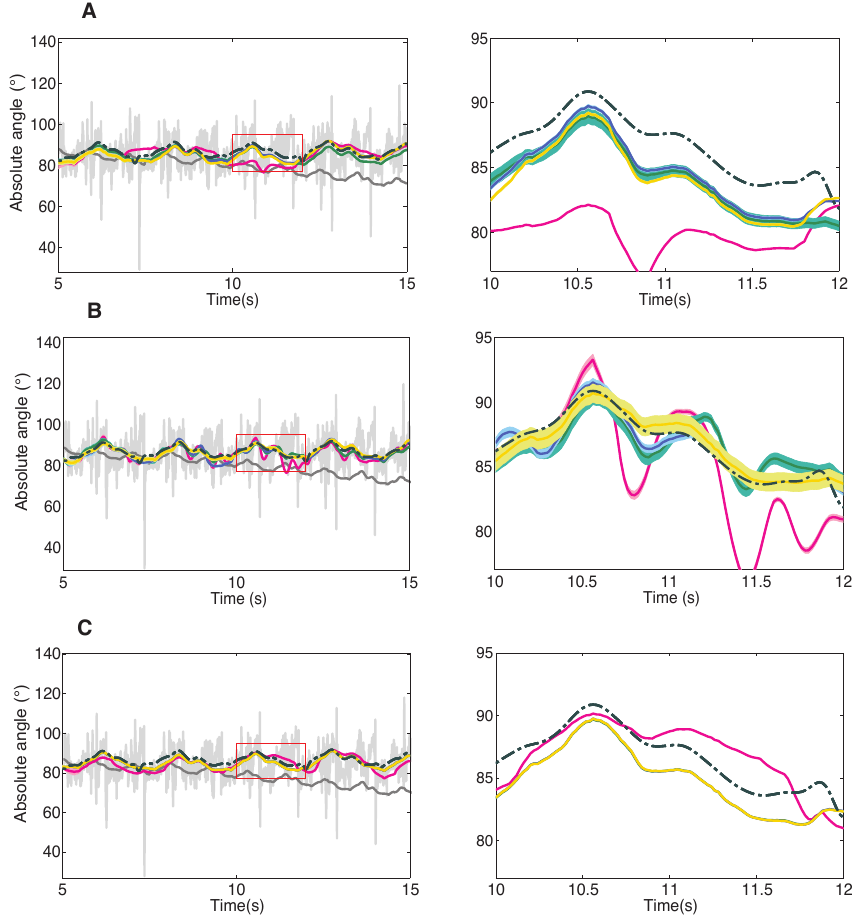
Figure 5. Performance of the Local KF (panel A ), Markovian KF (panel B ), and Matricial KF (panel C ). The calibrations are color coded with pink (cal. 1) and green (cal. 2) referring to the simplified calibrations; and purple (cal. 3) and yellow (cal. 4) referring to the complex calibrations. The thickness of each curve displays the variability in the corresponding estimates. The reference data obtained from the optic system is displayed in the discontinuous black line. The estimate based only on the accelerometers is displayed in light grey, the estimate based only on gyroscope data in dark grey.